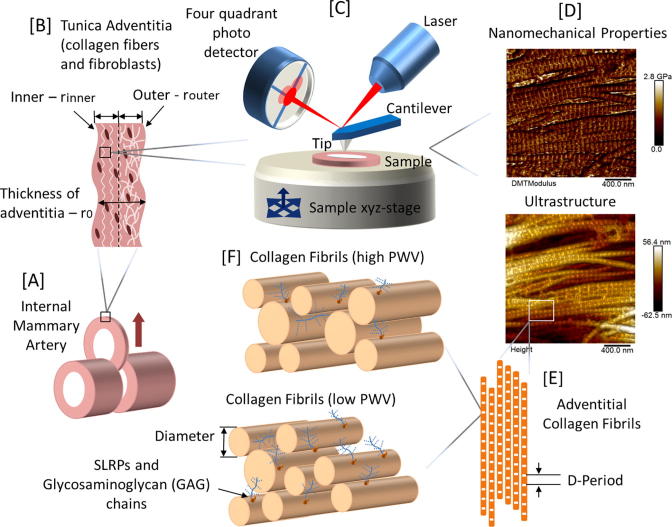
Schematic representation of the experimental approach (A) IMA sections (B) Location of adventitia for testing. Image analysis routine: (C) AFM imaging (D) Nanomechanical property measurement with PFQNM (E) and (F) Collagen fibril characterisation.